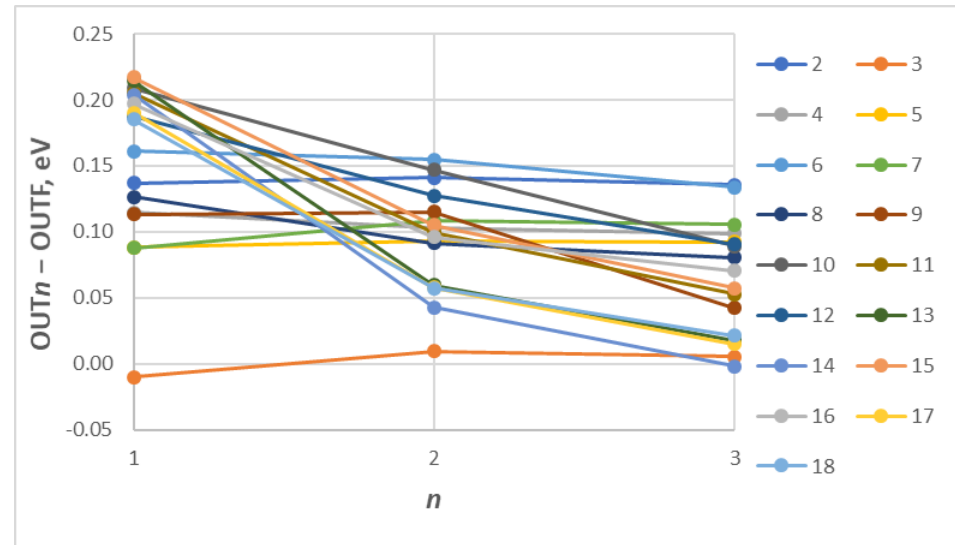
Figure 3. Difference of energy values of each output OUT n ( n = 1, 2, 3) from the final calculation for the 4f 13 5s5p configuration.